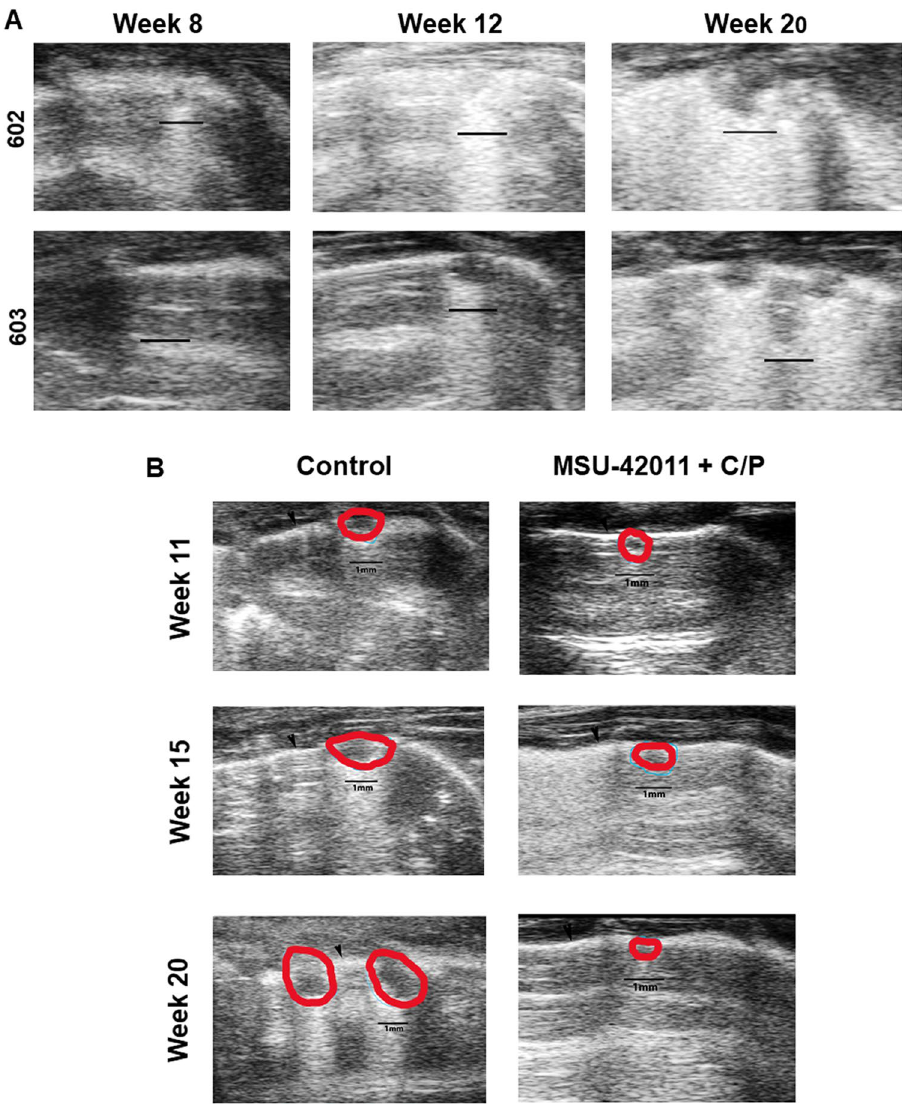
Figure 2. Ultrasound shows efficacy of MSU-42011 for treatment of established Kras-driven lung tumors. A/J mice were injected with vinyl carbamate to initiate the development of lung tumors. Ultrasound was used to monitor the progression of lung tumors 8, 12 and 20 weeks after initiation in 2 independent mice ( A ). In a separate experiment ( B ), treatment with MSU-42011 + carboplatin and paclitaxel (C/P) was started eight weeks after initiation, and ultrasound images of the same lung tumors were obtained 11, 15 and 20 weeks after initiation (or after 3, 7 and 12 weeks of treatment). Scale bar = 1